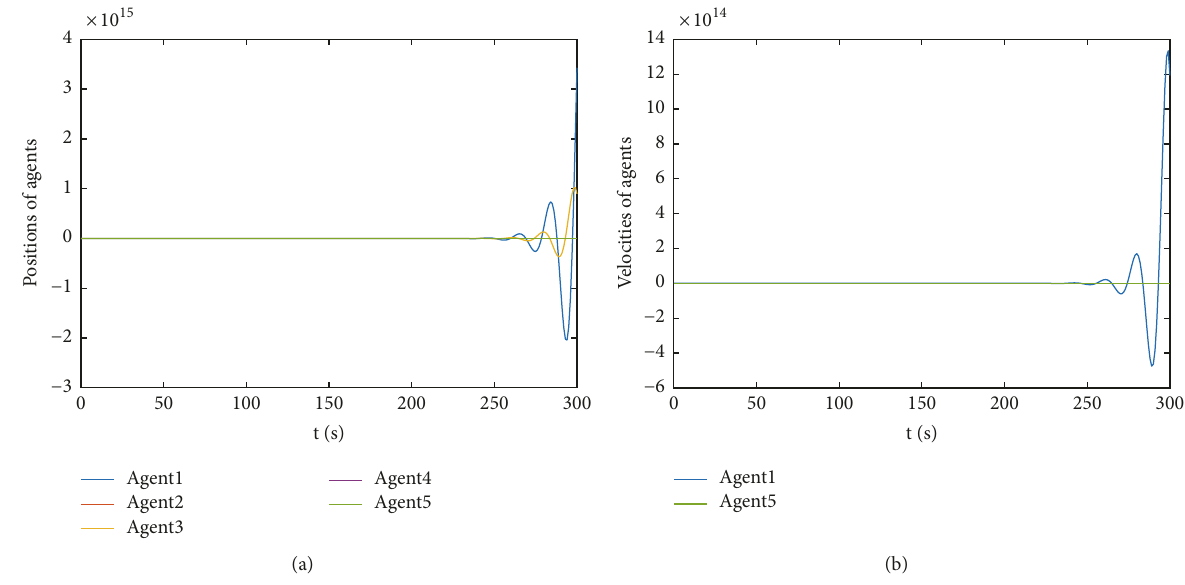
Figure 4: The state trajectories of the agents under directed topology in Figure 1 with different input time delays 𝜏 1 = 4.5 , 𝜏 2 = 4.5 , 𝜏 3 = 4.5 , 𝜏 = 4.5, 𝜏 = 0.5 , and 𝜏 = 1 . (a) Positions, (b) 4 5 𝑖𝑗